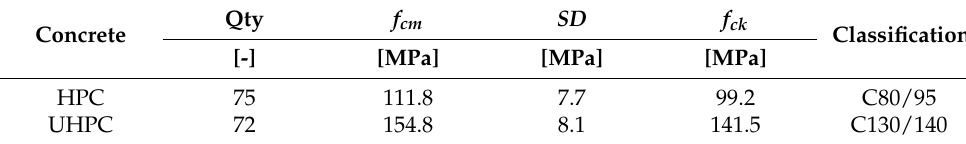
Table 2. Classification of concretes based on tests of seven SPP 2020 laboratories.